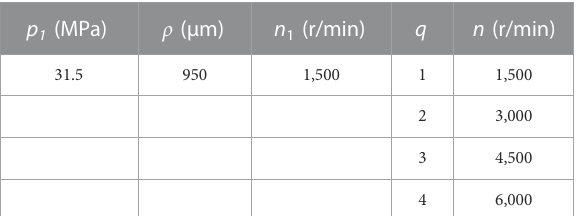
TABLE 4 High-speed simulation